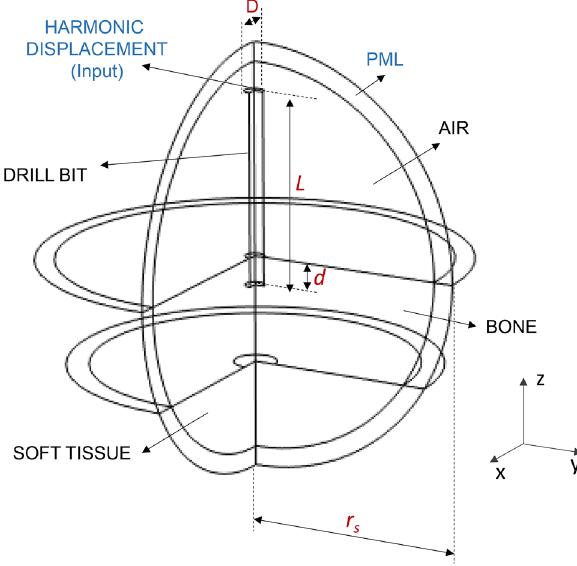
Figure 2. Schematic representation of the simulation